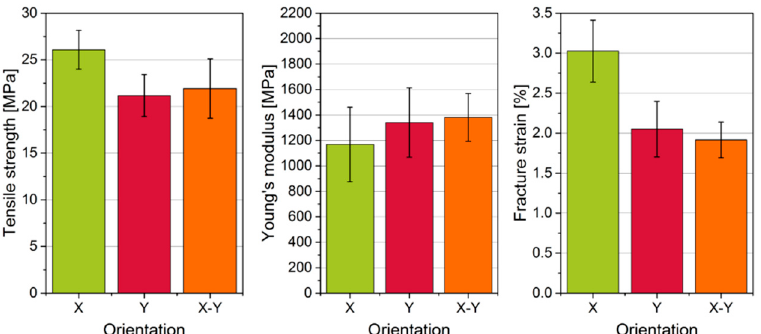
Figure 13. Tensile strength, Young’s modulus and fracture strain of differently aligned specimens in the SLS machine.